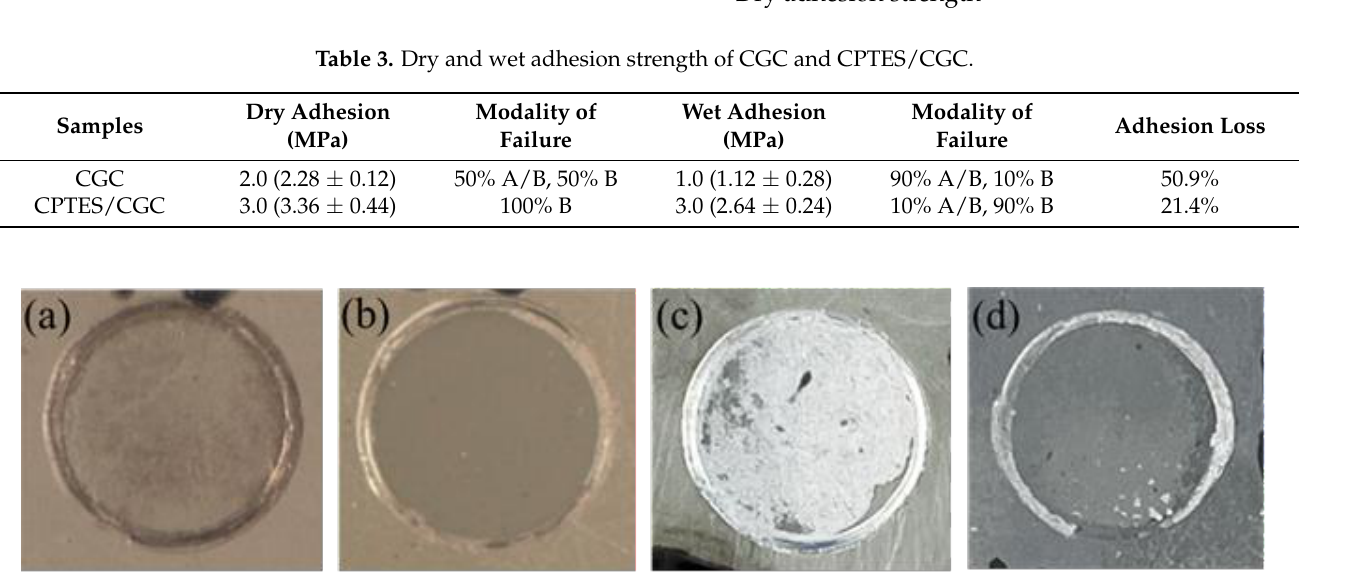
Figure 4. Digital photographs after the dry adhesion tests on, CGC ( a ) and CPTES/CGC ( b ) and the wet adhesion tests on, CGC ( c ) and CPTES/CGC ( d ) after 20 days of immersion in 3.5 wt % NaCl. Table 3. Dry and wet adhesion strength of CGC and CPTES/CGC.